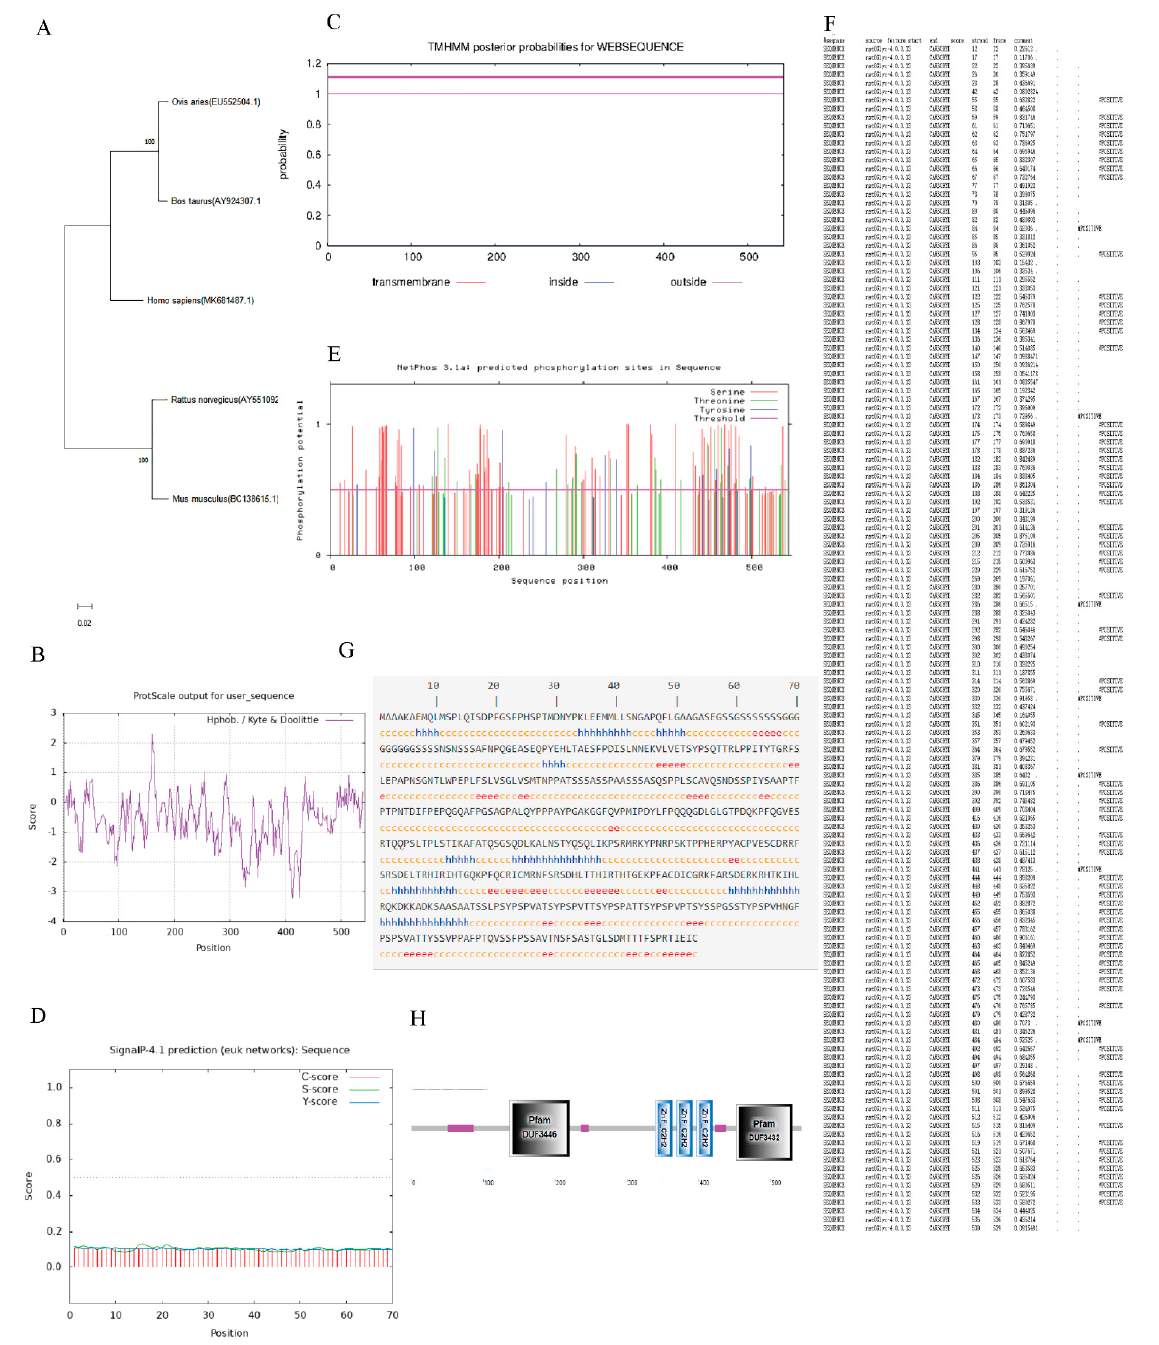
Figure 2. Bioinformatics analysis of EGR1 . ( A ) Phylogenetic tree of EGR1 between different species. ( B ) The hydropathy profile of EGR1 amino acid. ( C ) EGR1 protein transmembrane regional analyses. ( D ) EGR1 signal peptide prediction. ( E ) EGR1 phosphorylation site analyses. ( F ) EGR1 glycosyl site analyses. ( G ) EGR1 protein secondary structure prediction. ( H ) EGR1 conservative structure domain analyses.